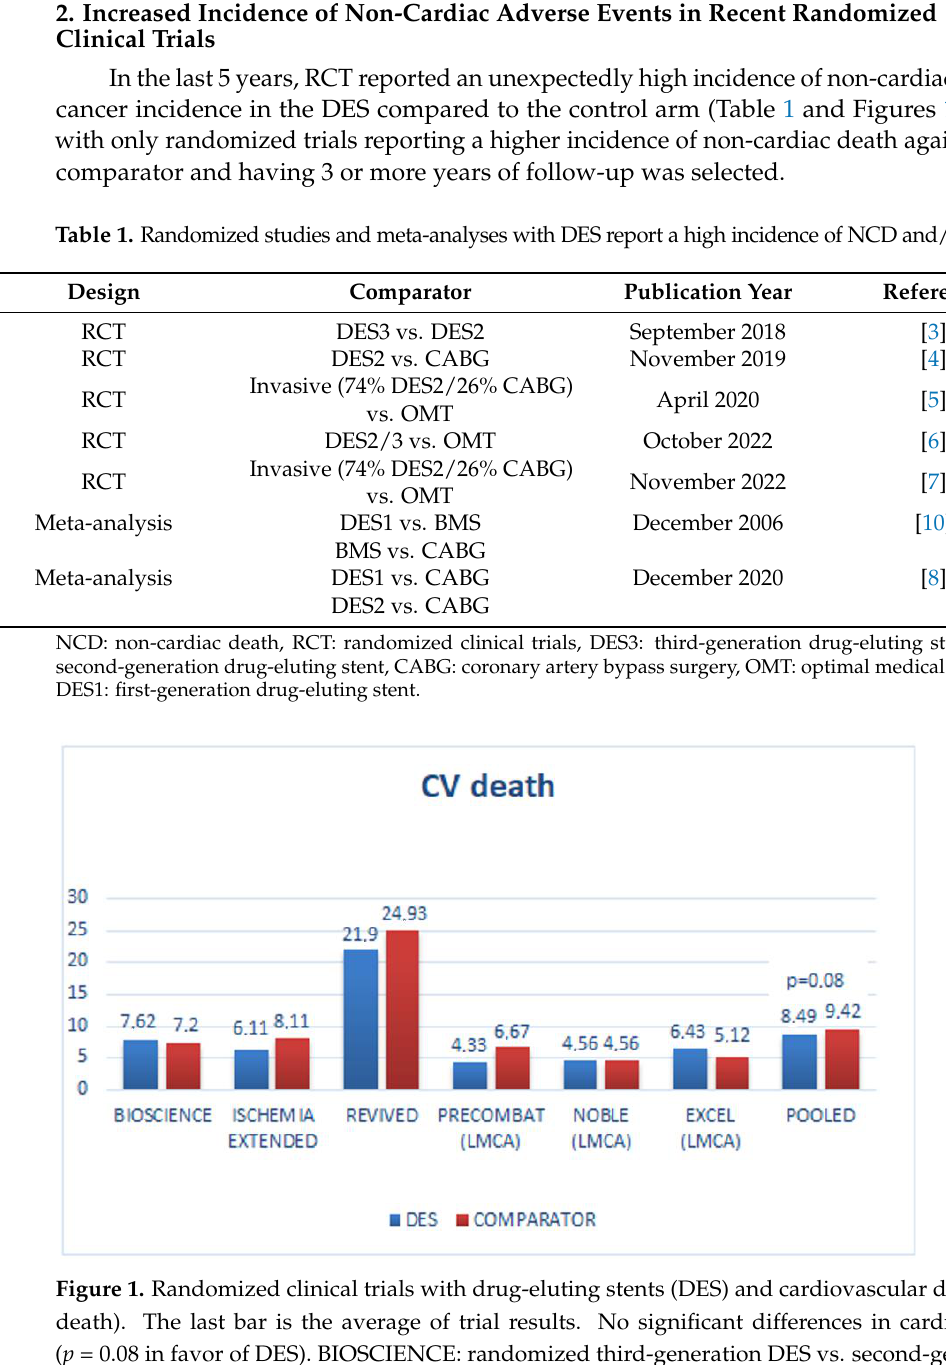
Figure 2. Randomized clinical trials with DES, non-cardiovascular death (non-CV death at long- term follow-up.) The last bar is the average of trial results. Significant differences in non-CV death ( p = 0.000018 in favor of comparator). Acronyms, abbreviations, and trial designs are described in Figure 1. As described in Table 1, follow-up length was 5 years in BIOSCIENCE (2119 patients) and EXCEL (1905 patients), 5.7 years in ISCHEMIA EXTENDED (4825 patients), 3.4 years in REVIVED (700 patients), and 3.2 years (5179 patients) in ISCHEMIA. 3. Trials List (Table 1) 1. In 2018, a BIOSCIENCE trial (3) compared a new biodegradable sirolimus thin stent struts design vs. an everolimus durable polymer design. The trial was an initial in- vestigator, single-blind, multicenter, randomized, non-inferiority trial. Patients were